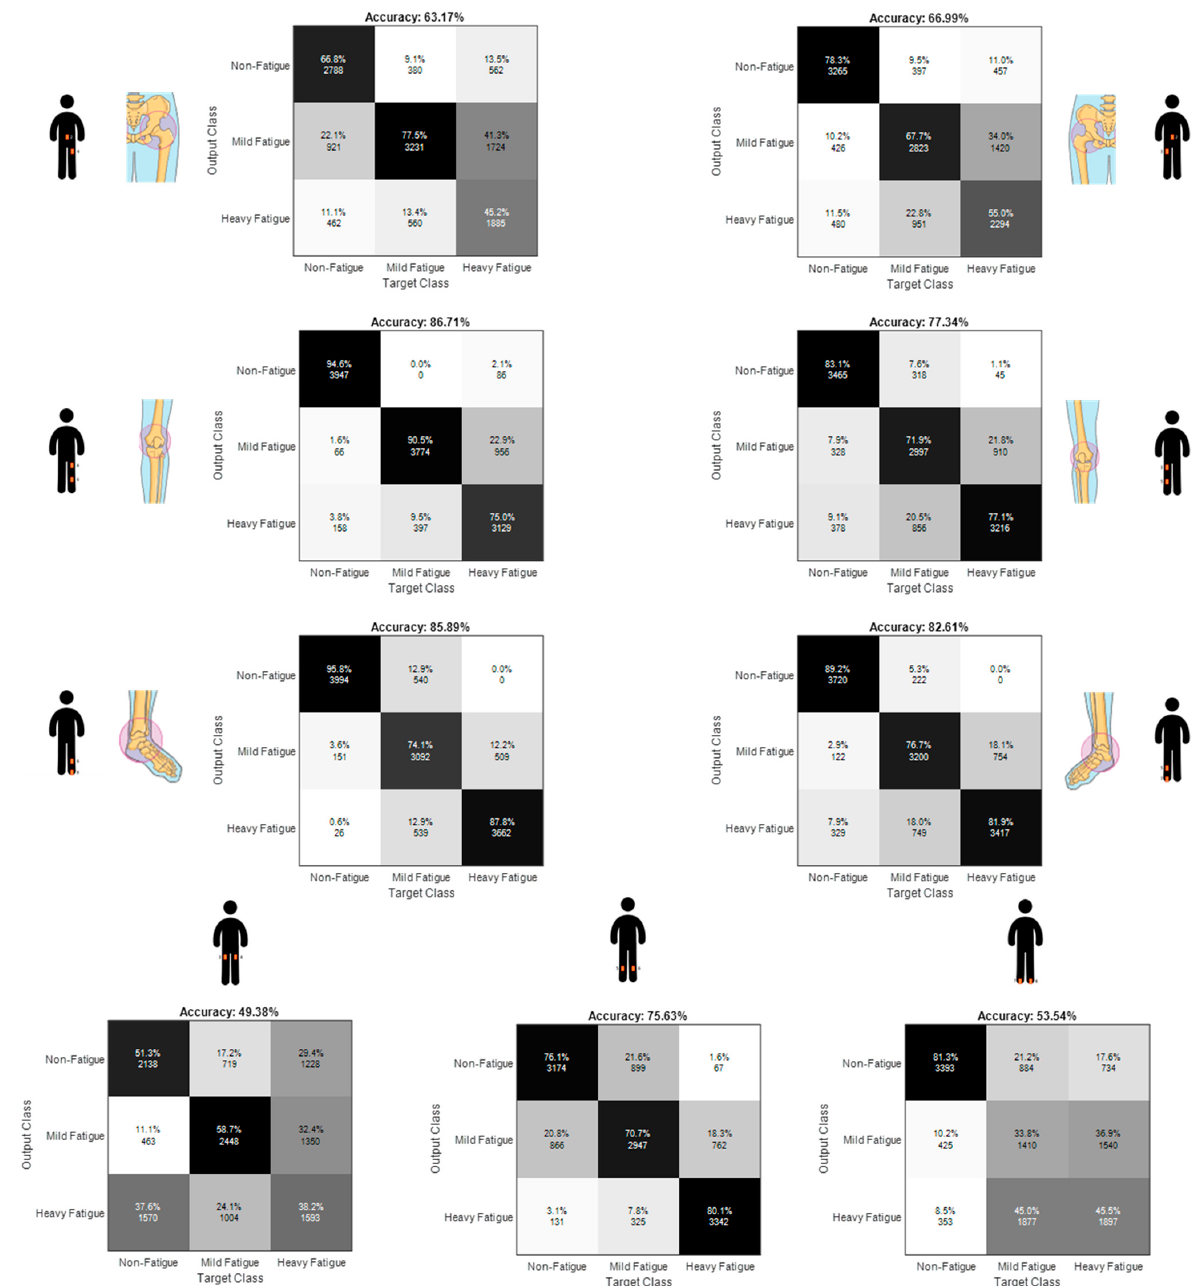
Figure A2. Aggregate confusion matrices with all subjects, quasi-minimally intrusive IMU configurations. Joints present in each configurations are shown.